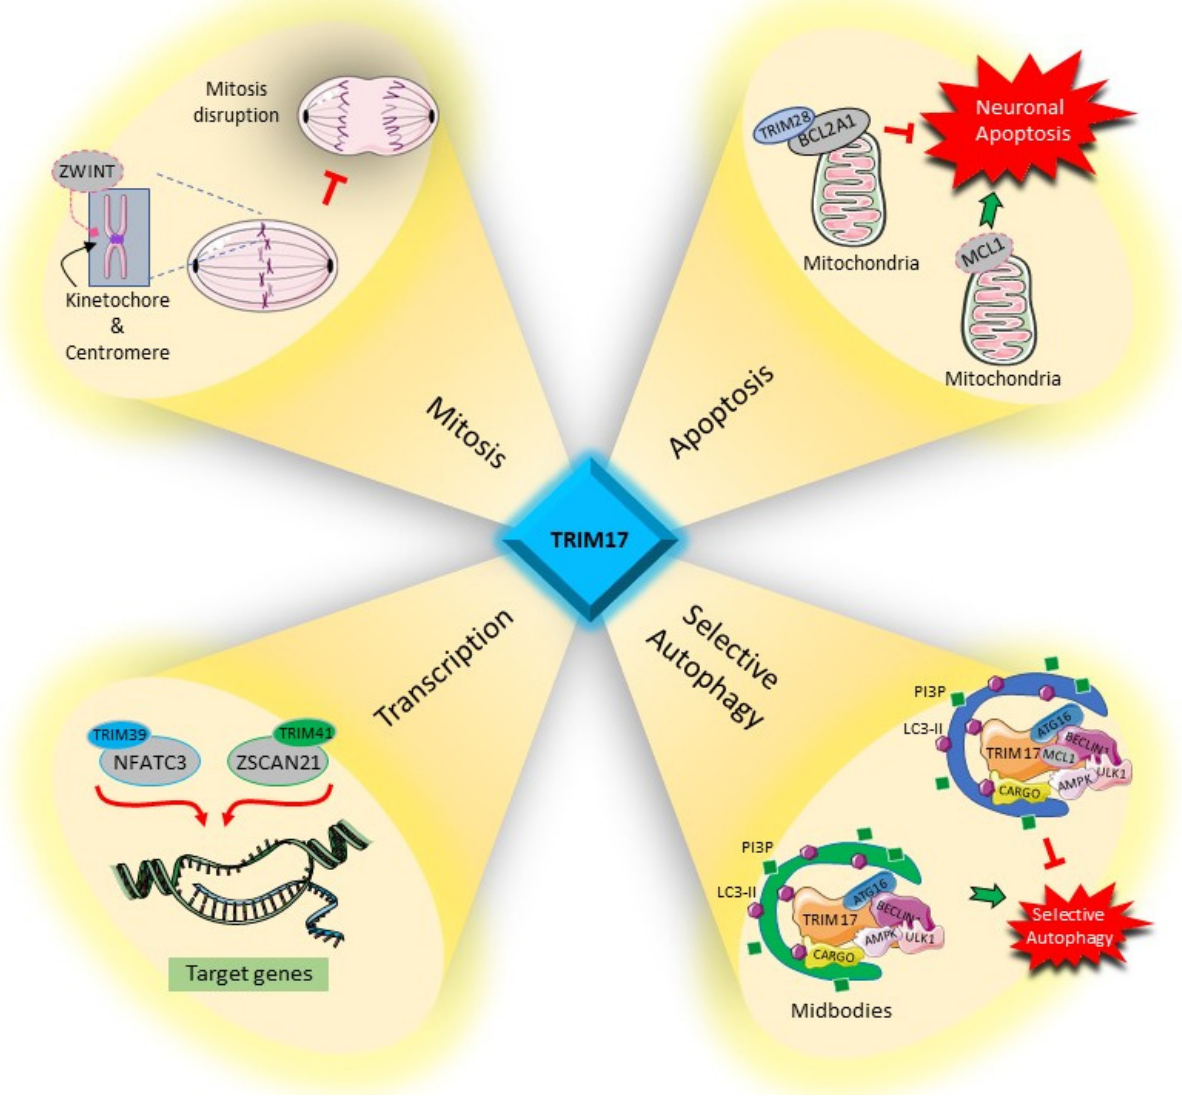
Figure 8. Cellular functions of TRIM17.